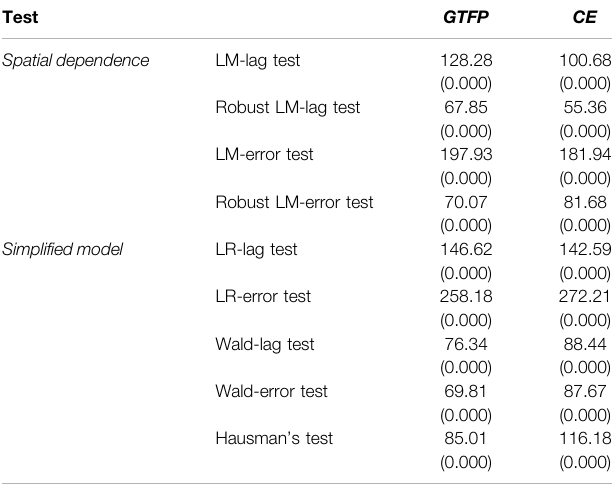
TABLE 4 | Test results of the setting model.